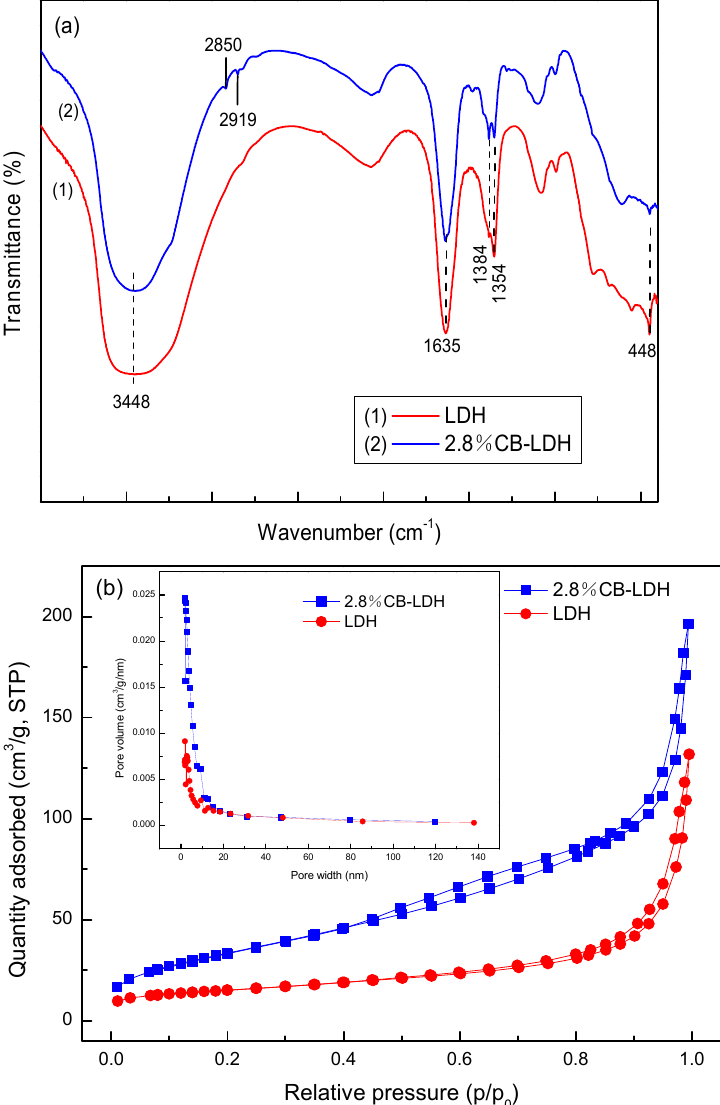
Figure 2. FTIR spectra ( a ) and the N 2 adsorption–desorption isotherms and pore size distribution curve ( b ) of MgAl-LDH.